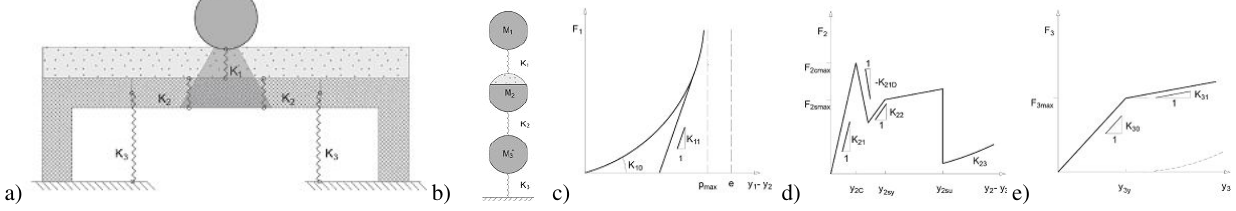
Fig. 15. System with multiple degrees of freedom (SMDF) a) and b), from the section of a gallery to the model definition together with the force-displacement relationship of the springs for c) cushion layer, d) shear behaviour and e) global bending stiffness (from Schellenberg and Vogel, 2009).